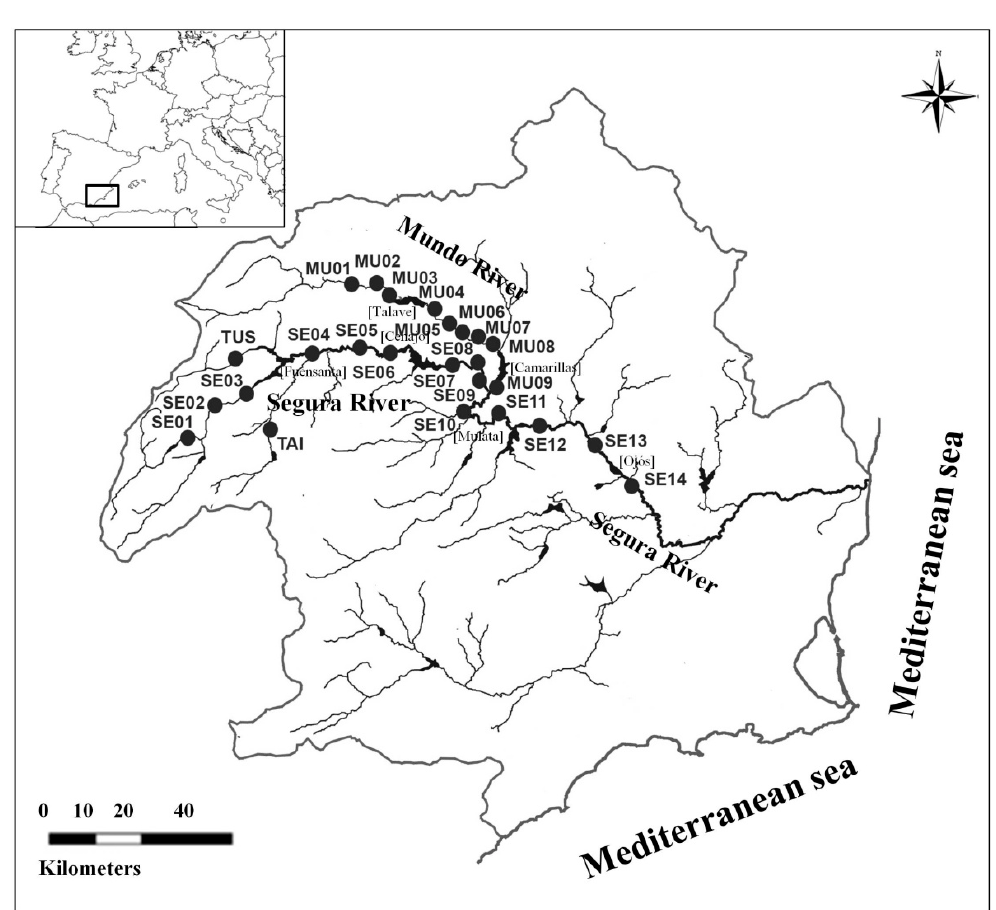
Figure 1. Study area. Location of the Segura River basin in the southeast of the Iberian Peninsula. Sampling sites are marked ( ● ): TAI (Taibilla River), TUS (Tus River), MU (Mundo River) and SE (Segura River). Names of large reservoirs are between parentheses [].